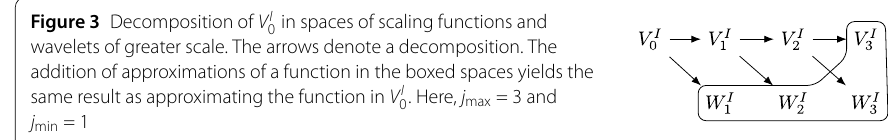
Figure 3 Decomposition of V I 0 in spaces of scaling functions and wavelets of greater scale. The arrows denote a decomposition. The addition of approximations of a function in the boxed spaces yields the same result as approximating the function in V I 0 . Here, j max = 3 and j min =